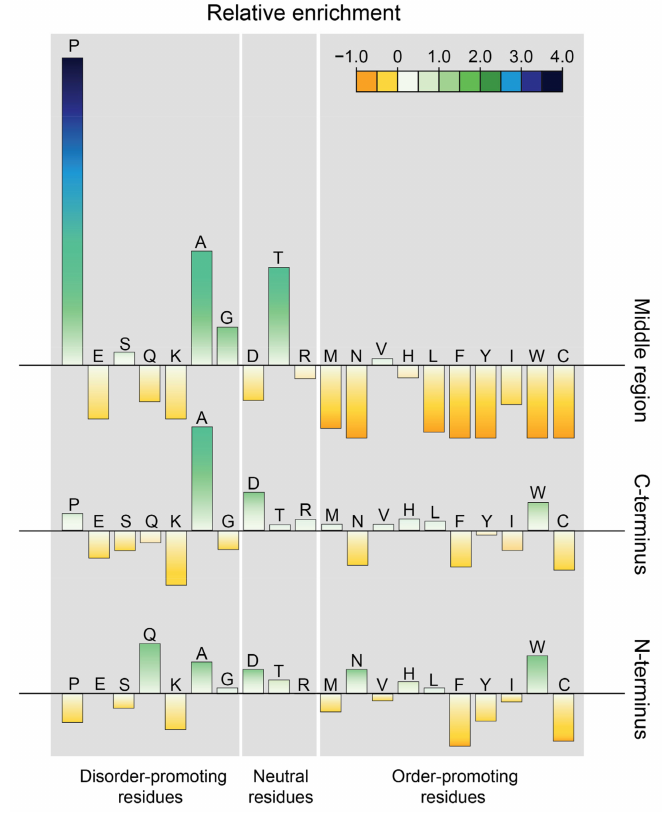
Figure 1. Relative amino acid enrichment in the different regions of EspK compared to proteins deposited in the protein data bank [36]. Enrichment calculated as (AA EspK -AA PDB )/AA PDB , where AA EspK is the content of an amino acid in EspK, and AA PDB is the corresponding amino acid content of a subset of structured proteins. Amino acids are distributed according to their (dis)order-promoting